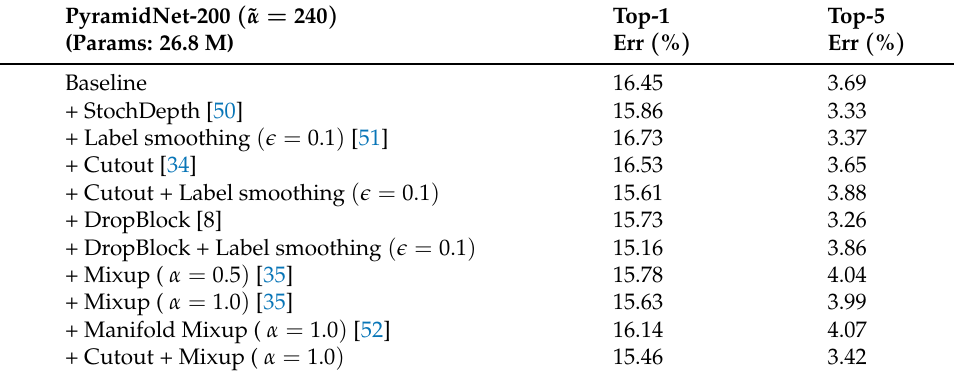
Table 2. Comparison of state-of-the-art regularization methods on CIFAR-100. First best and second best performances are highlighted in blue and red color,